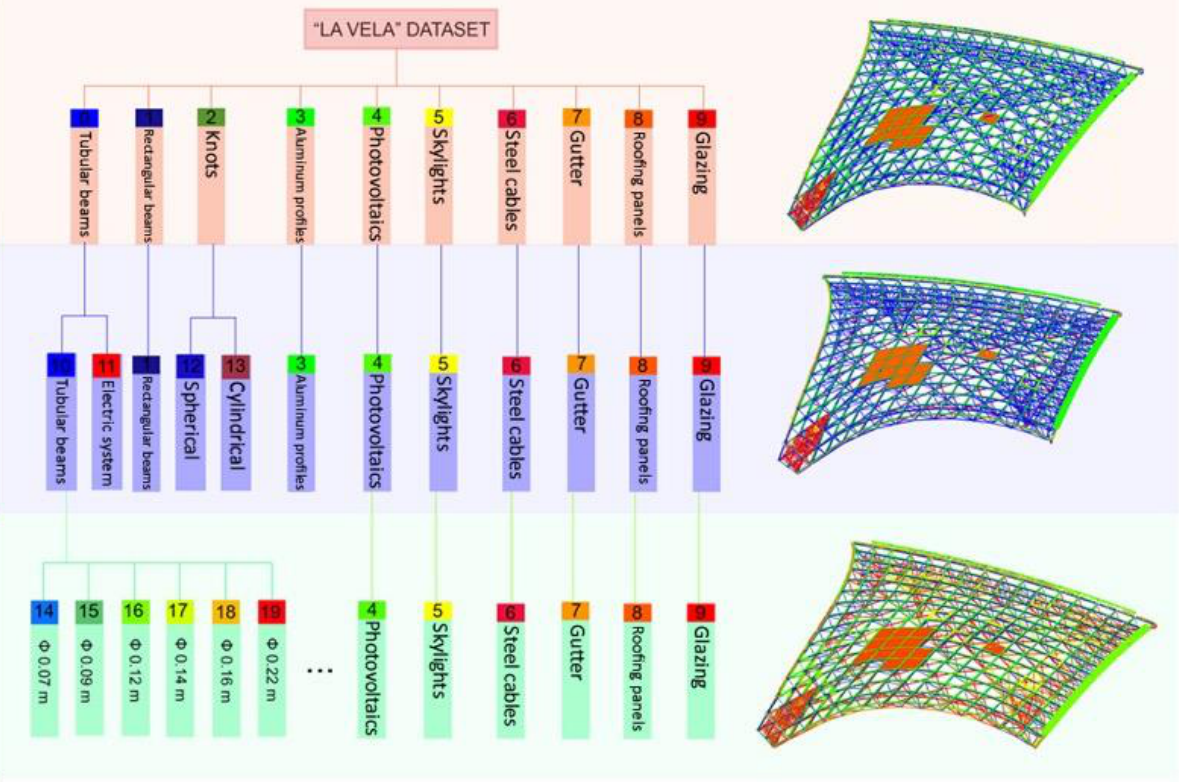
Figure 10. Tree diagram of the structure classification phase.